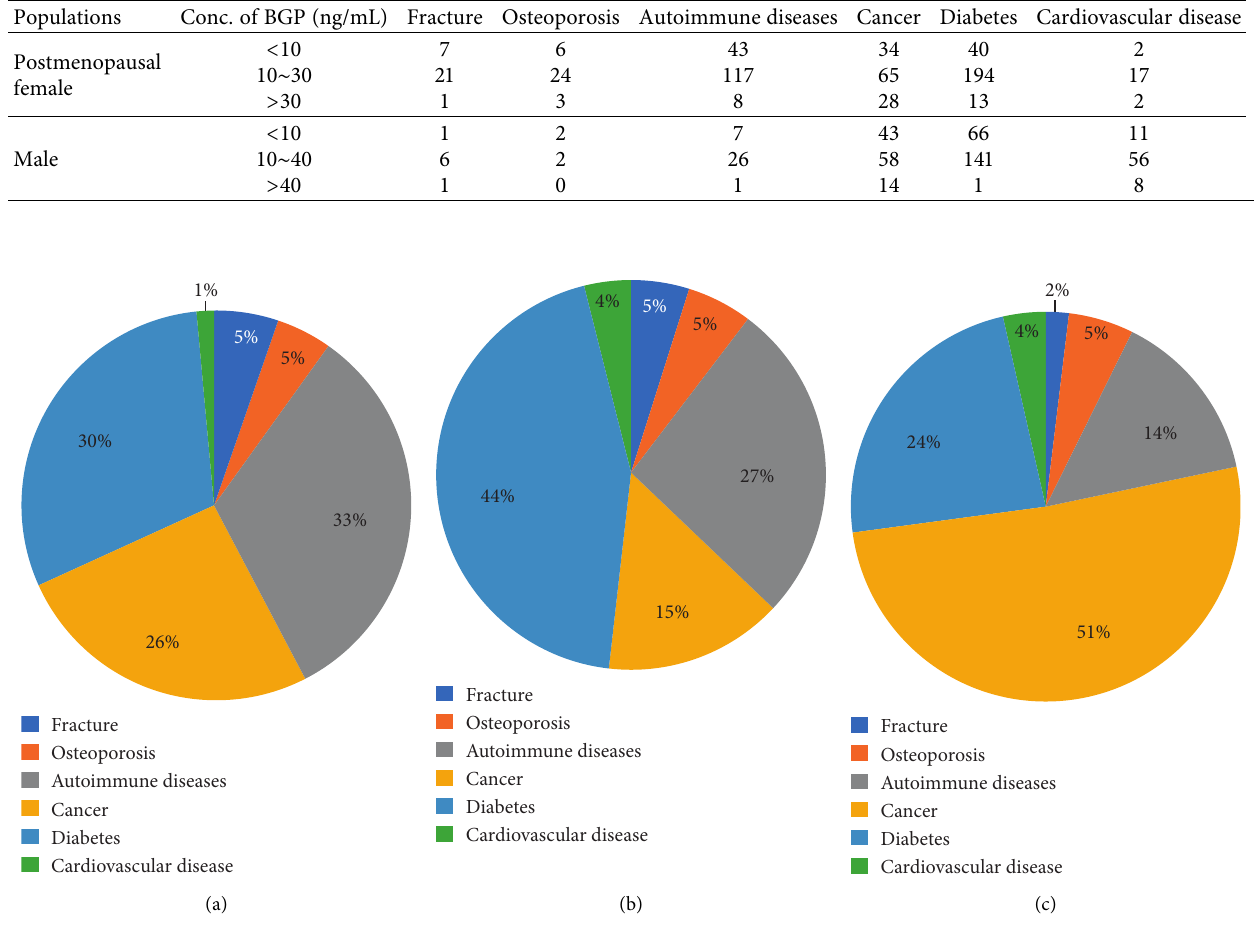
Figure 6: Distribution of clinical samples from postmenopausal women. (a) BGP < 10ng/mL. (b) BGP within 10–30ng/mL. (c) BGP >